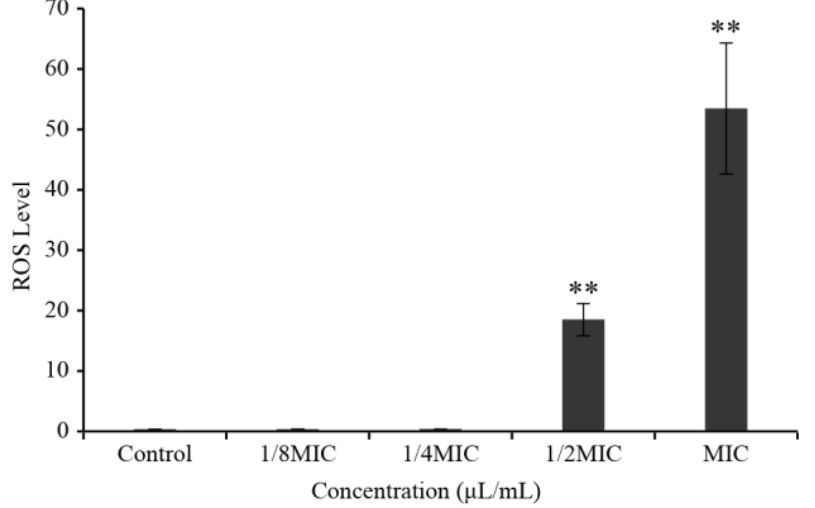
Figure 2. Intracellular ROS level in C. sakazakii treated with LC-EO (** p < 0.01).